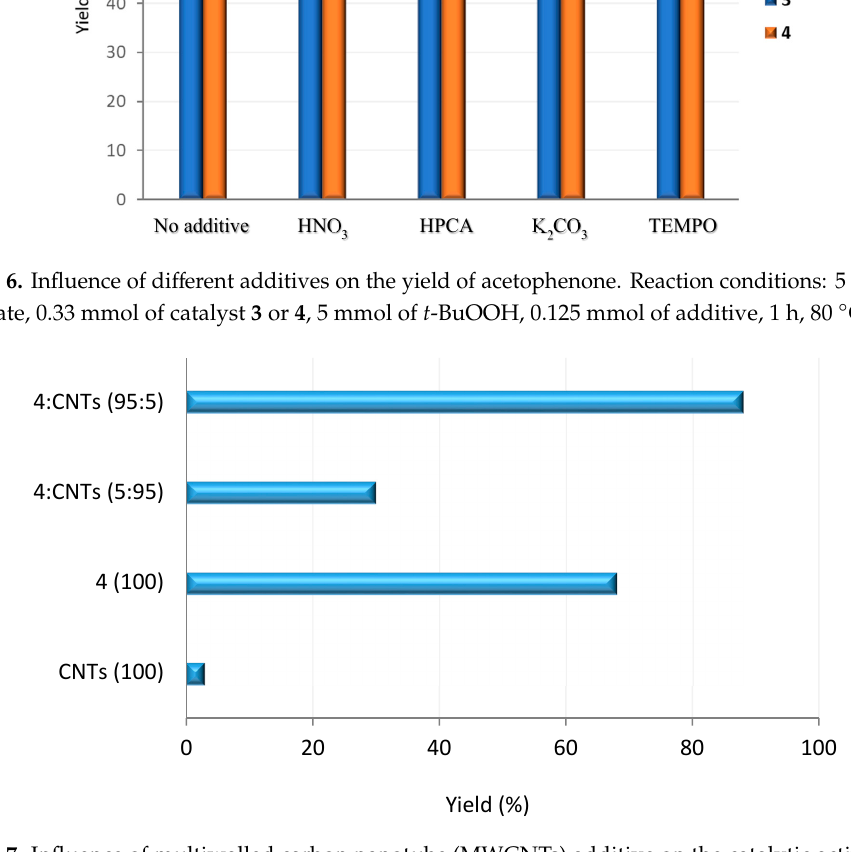
Figure 7. Influence of multiwalled carbon nanotube (MWCNTs) additive on the catalytic activity of 4 . Reaction conditions: 5 mmol of substrate, 0.33 mmol of catalyst, 5 mmol of t -BuOOH, 1 h, 80 °C, 5 W.